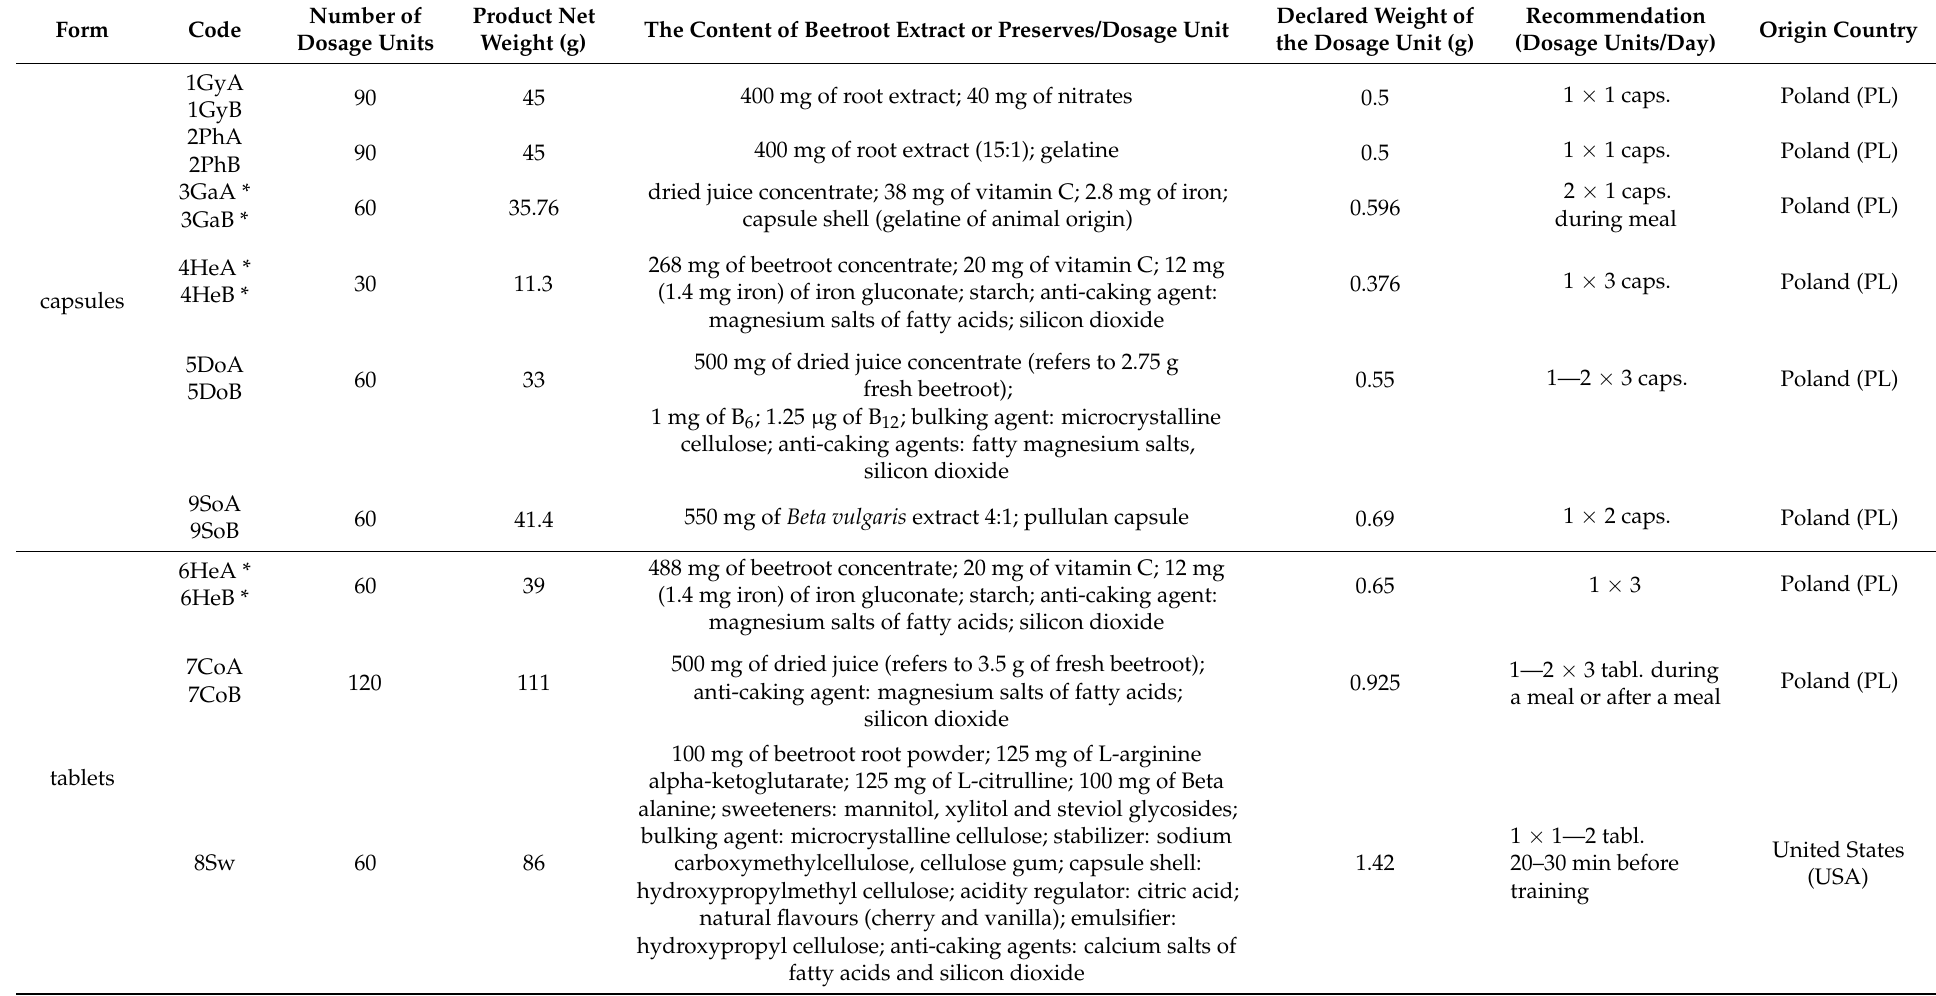
Table 2. Full characteristics of the analysed beetroot-based dietary supplements according to information on the package ( * iron-enriched